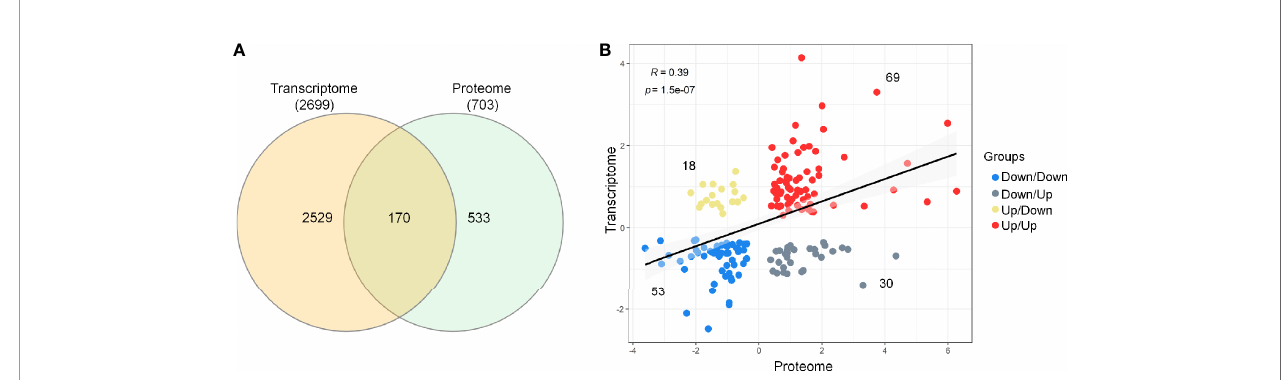
FIGURE 2 | Comparison and correlational analysis between transcriptome and proteome. (A) The Venn diagram represents unique and shared genes/proteins between transcriptome and proteome. (B) Scatter plot showing the Spearman ’ s correlation between the mRNA and protein expression